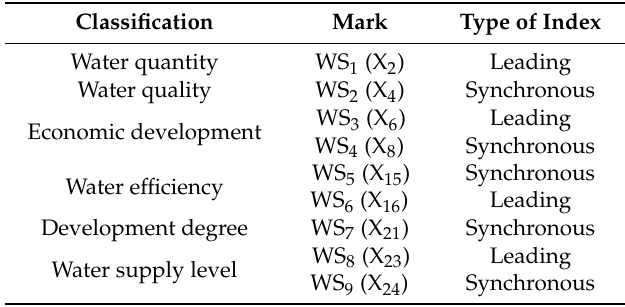
Table 4. Early warning sign indices for EWS-RWRCC in Anhui Province.